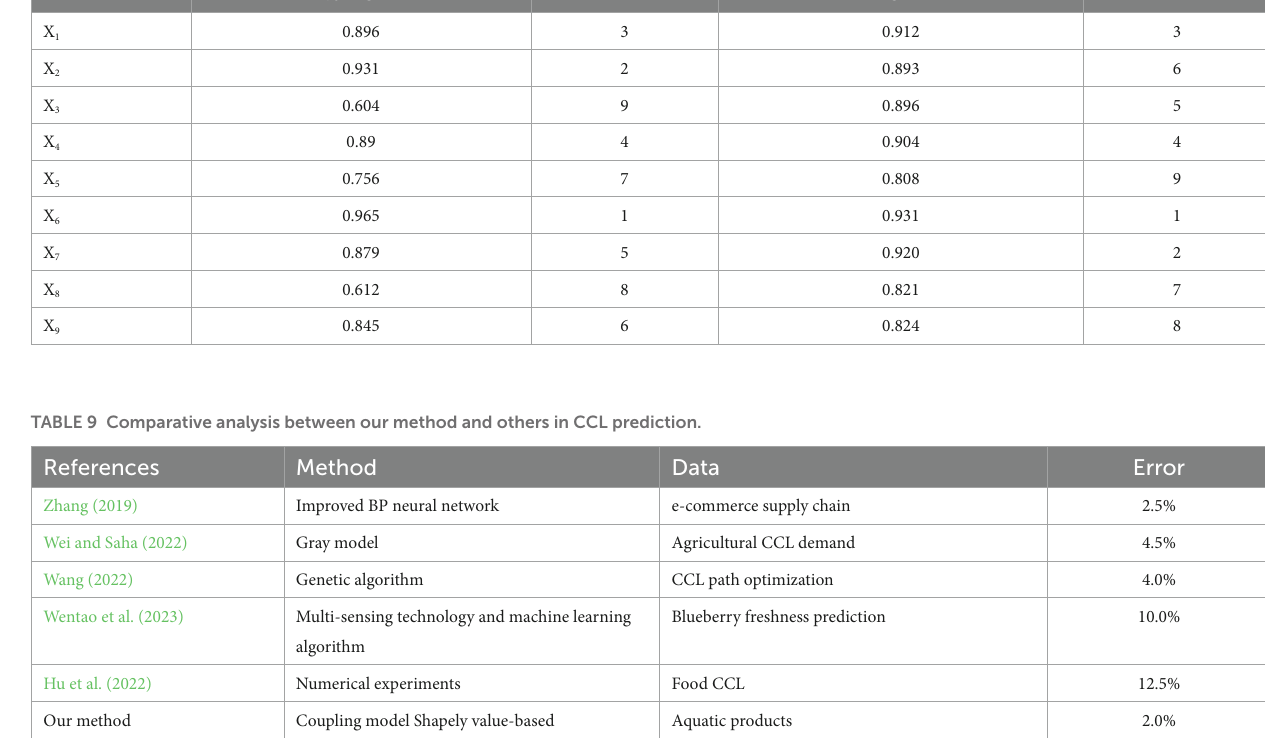
algorithm, a deep learning algorithm based on Seq2Seq + Attention is